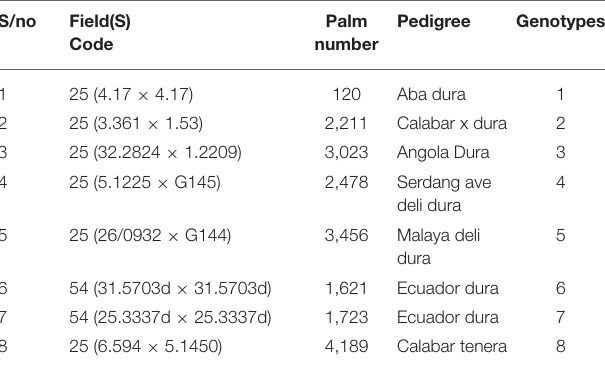
TABLE 2 | Background derivation of susceptible and tolerant oil palm genotypes screened.